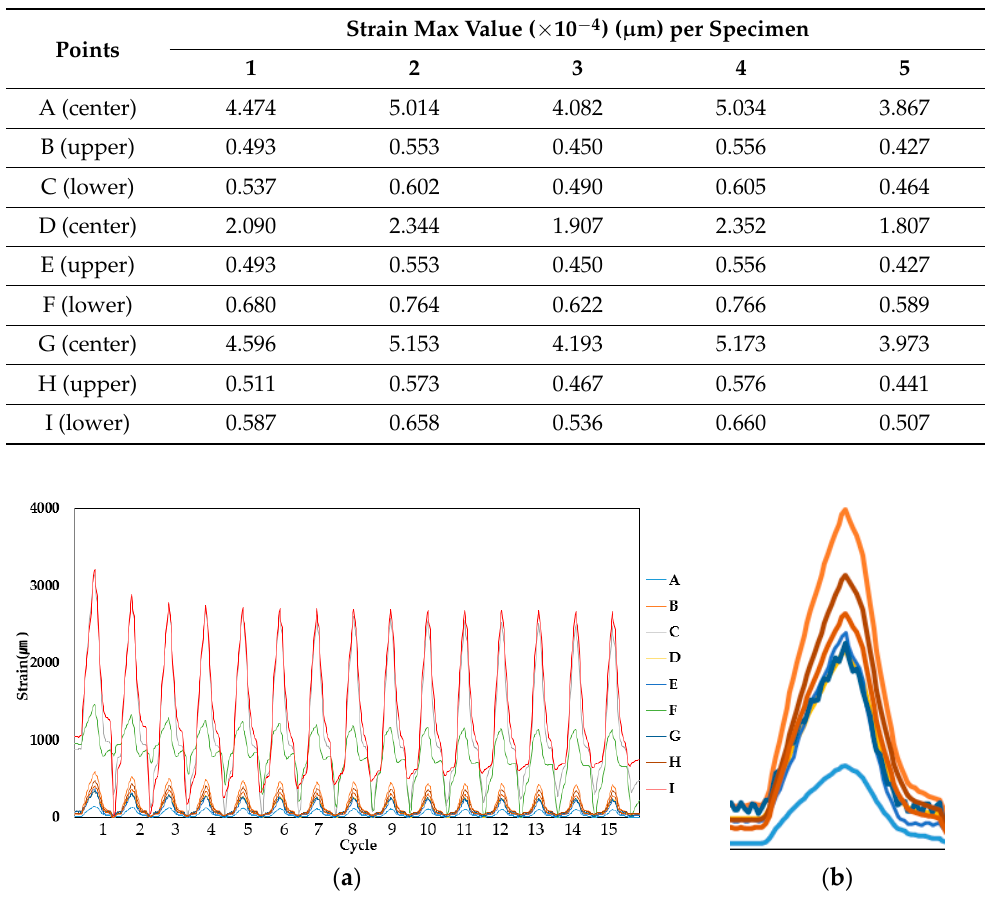
Table 4. Sample strain measurement results for each strain gauge point (averaged peaks).